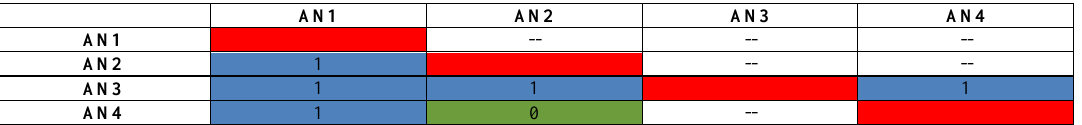
Table 21. Dominating interaction matrix of actions for performance PM1.